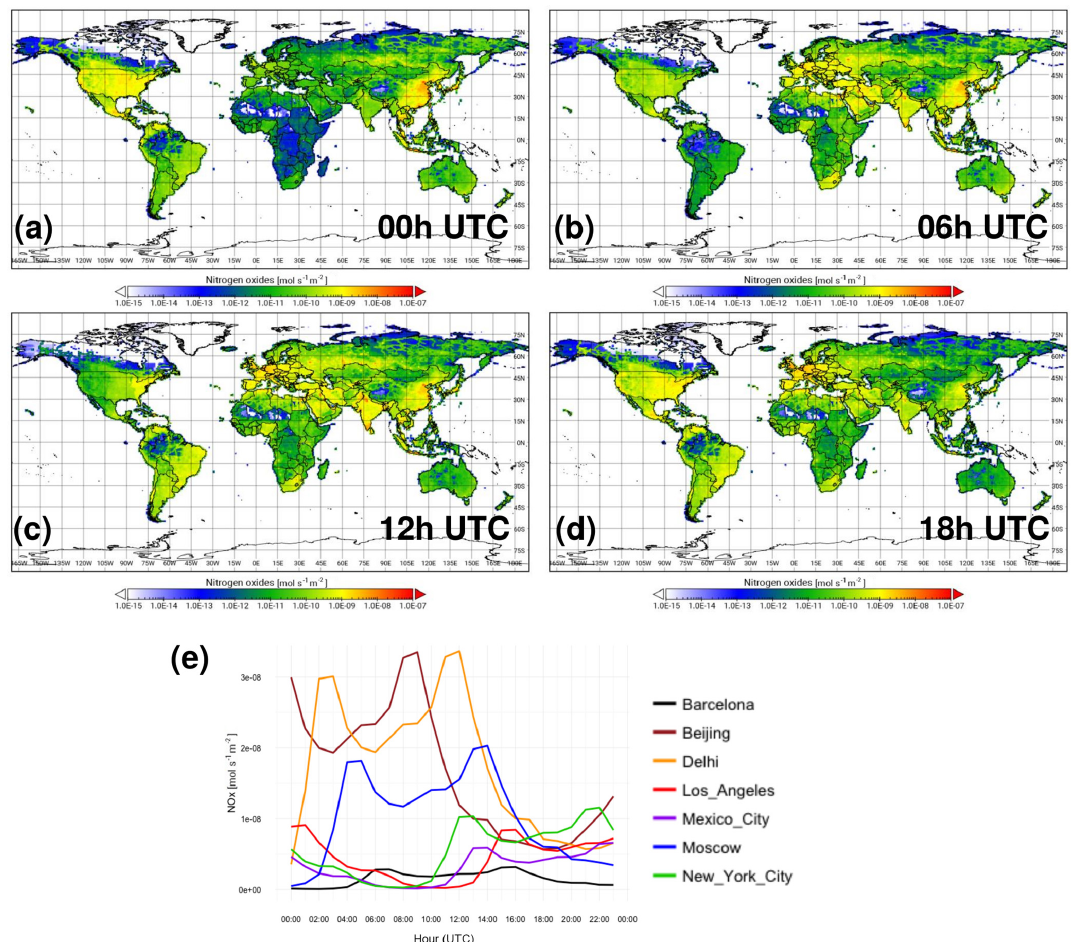
Figure 5. Global hourly NO x transport emissions (mols − 1 m − 2 ) derived from ECLIPSEv5a at 00:00 (a) , 06:00 (b) , 12:00 (c) and 18:00 (d) UTC and the diurnal evolution estimated in the grid cells where different global cities are located (e)